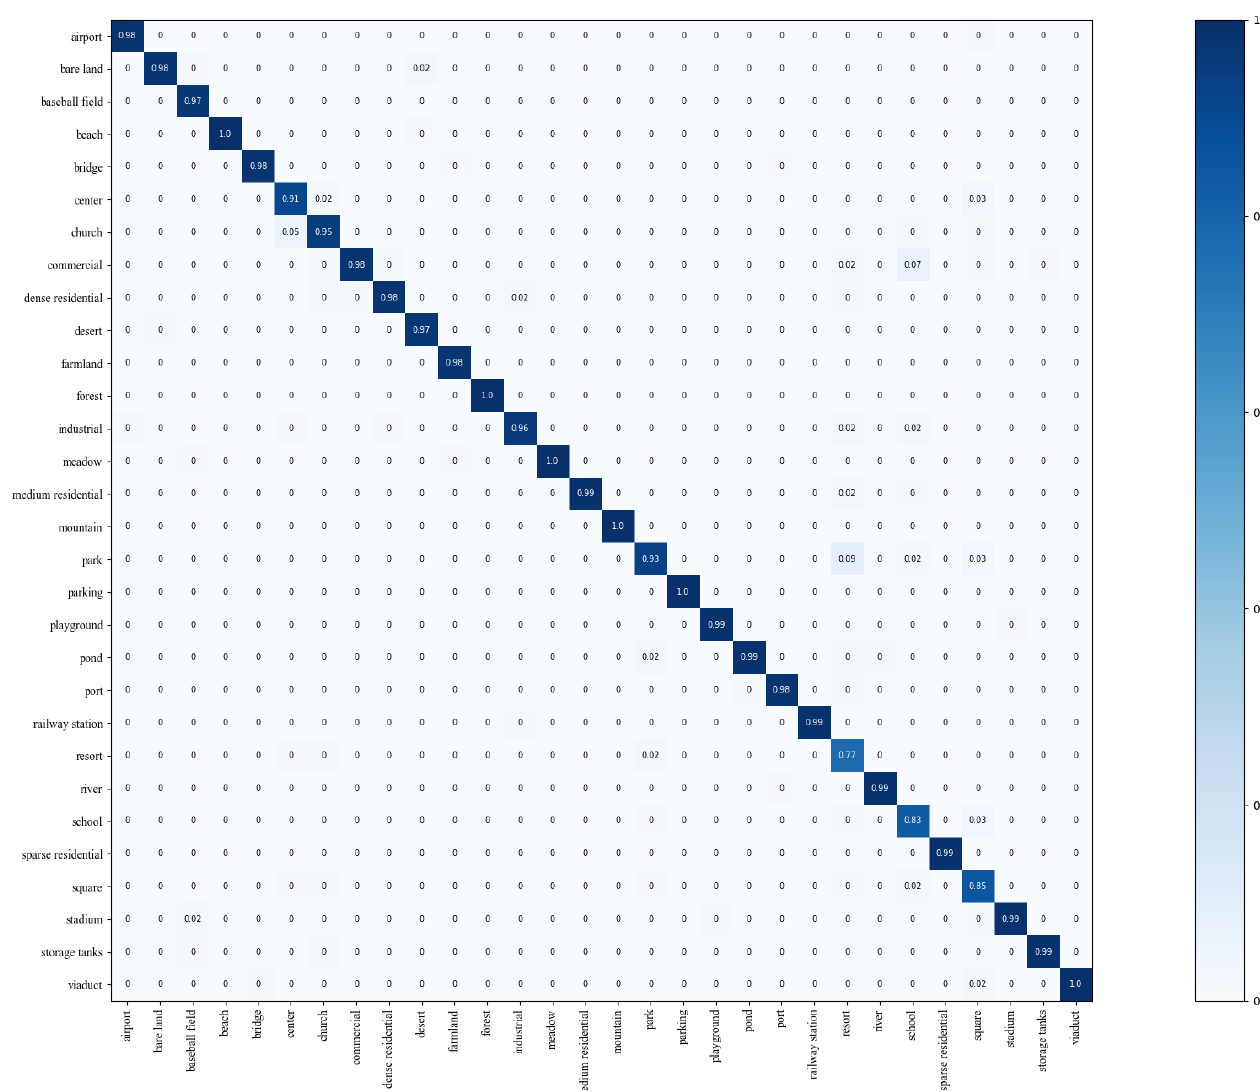
Figure 4. Confusion matrix in AID using LSRL at training ratio of